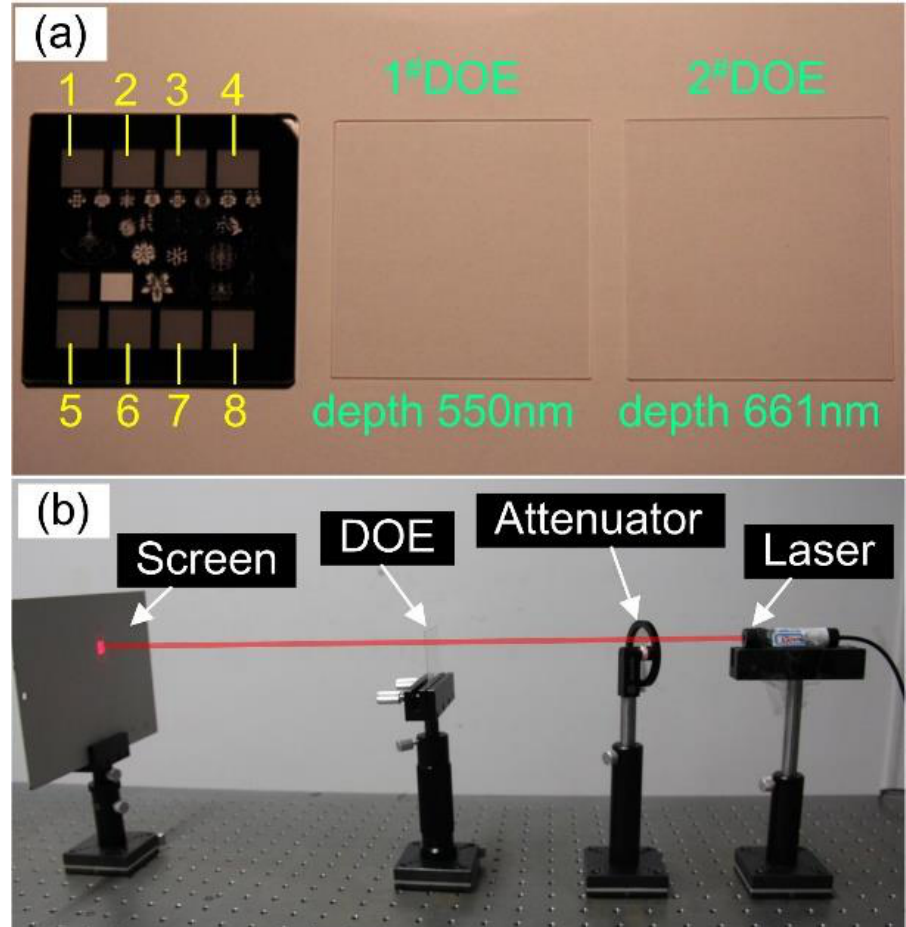
Figure 7. ( a ) mask and the fabricated DOEs; ( b )Experimental test system.